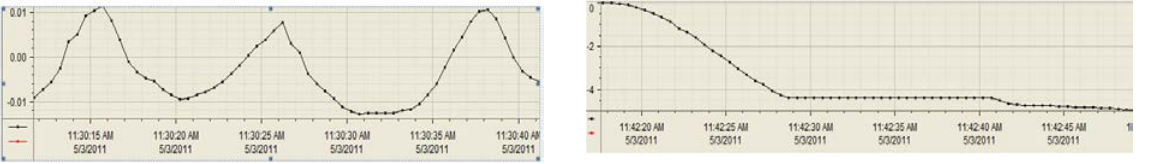
Figure 14. Payload position for load case 1, with inner loop P = 0.001, I = 0.031, D = 0.